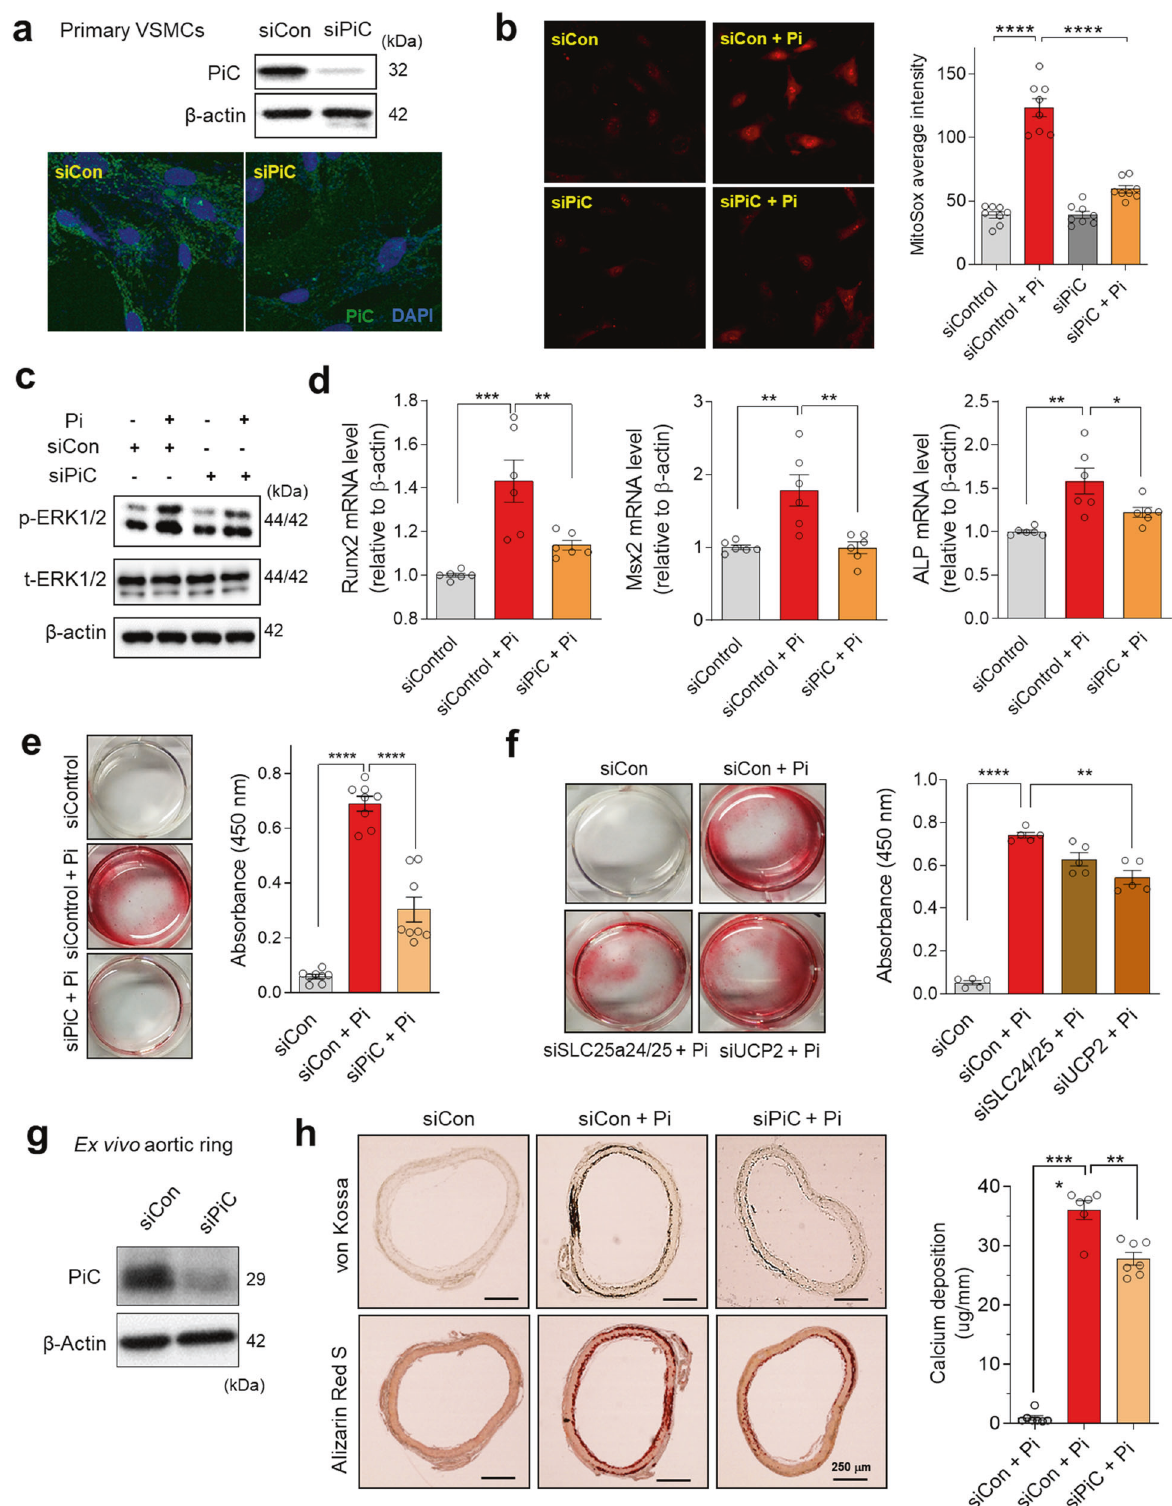
showed the greatest protective activity against Pi-induced calci fi ca- tion, other routes for mitochondrial Pi uptake also contribute to calci fi c progression in pVSMCs. Instead of silencing multiple transporters, we utilized nonselective pharmacological blockers of mitochondrial Pi transporters, butylmalonate (BMA), and mersalyl.